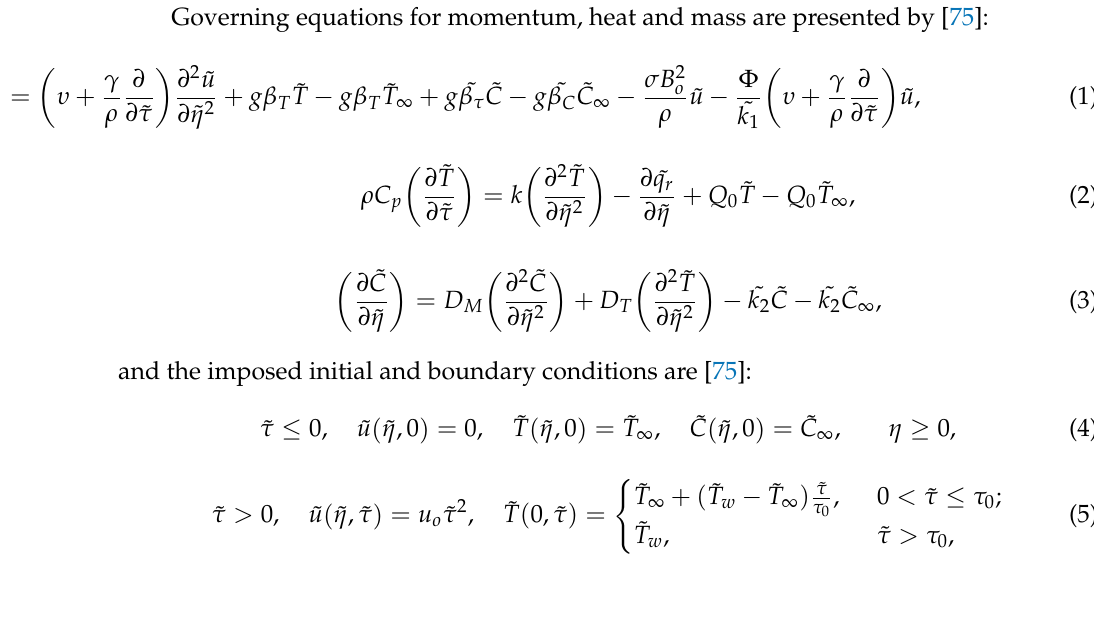
Figure 1. Geometrical presentation of the